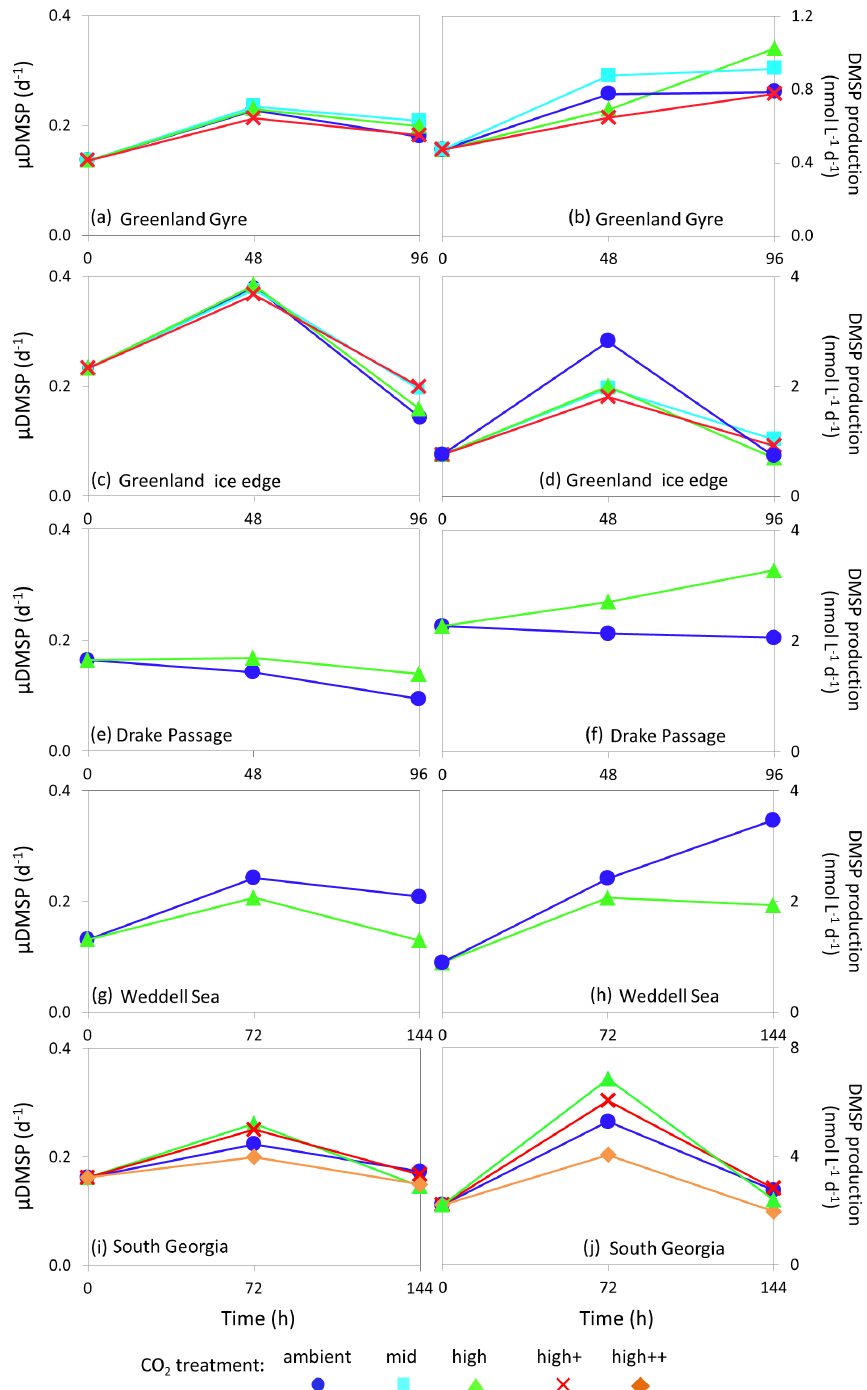
Figure 6. De novo synthesis of DMSP ( µ DMSP, d − 1 ) (left column) and DMSP production rates (nmolL − 1 d − 1 ) (right column) for Arctic Ocean stations Greenland Gyre (a, b) and Greenland Ice-edge (c, d) and Southern Ocean stations Drake Passage (e, f) , Weddell Sea (g, h) and South Georgia (i, j) . No data are available for Barents Sea (Arctic Ocean) or South Sandwich (Southern